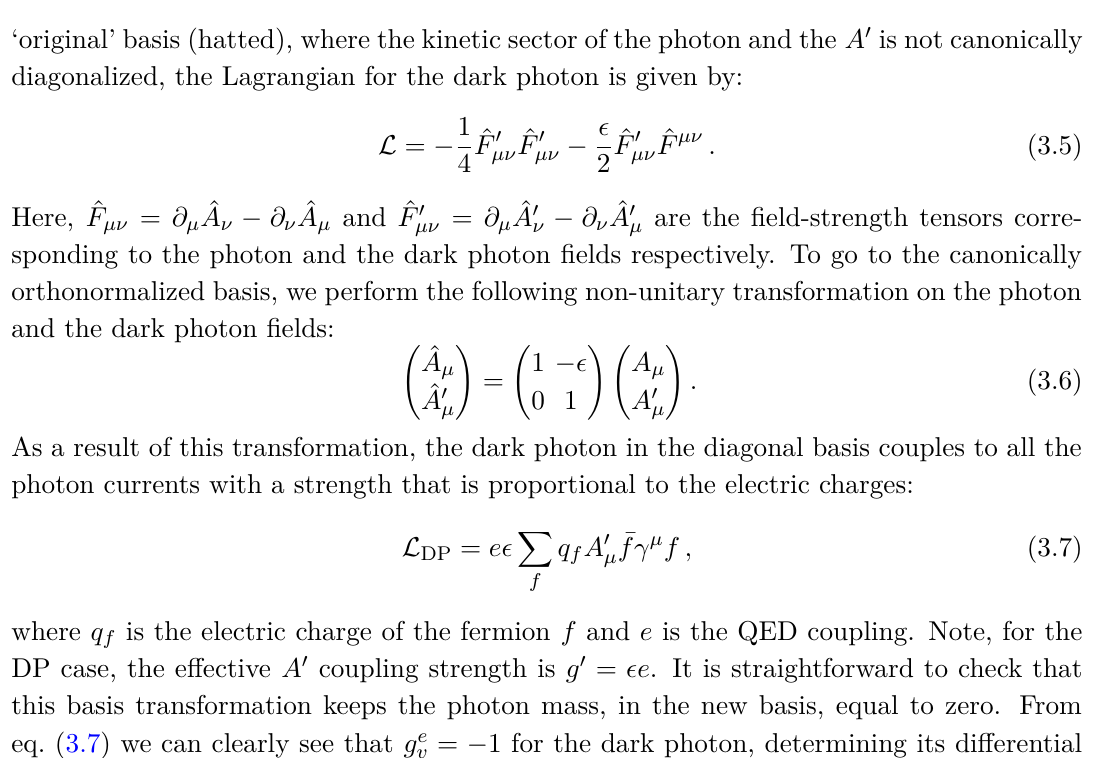
Figure 3 . We plot the partial widths and the branching ratios of the dark photon for different channels of decay, as denoted in the legend. The black dashed line in the top panel indicates the total width of the particle. We have plotted a scaled version of the decay width to remove the dependence on the